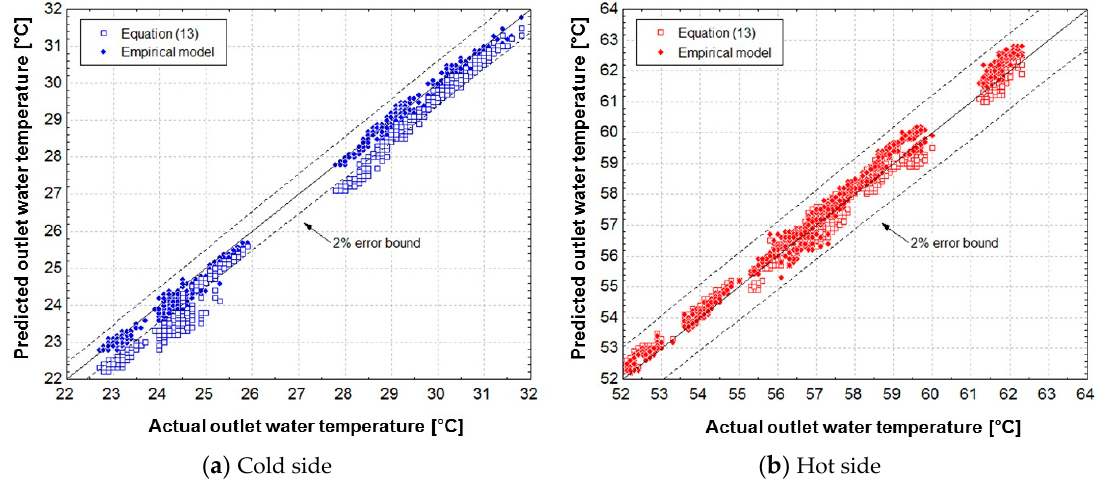
Figure 6. Prediction results of the outlet temperature using the empirical and theoretical models.